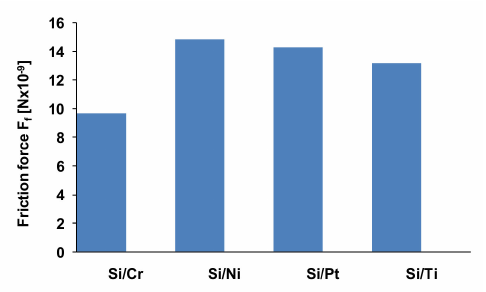
Figure 23. Friction forces for investigated samples.